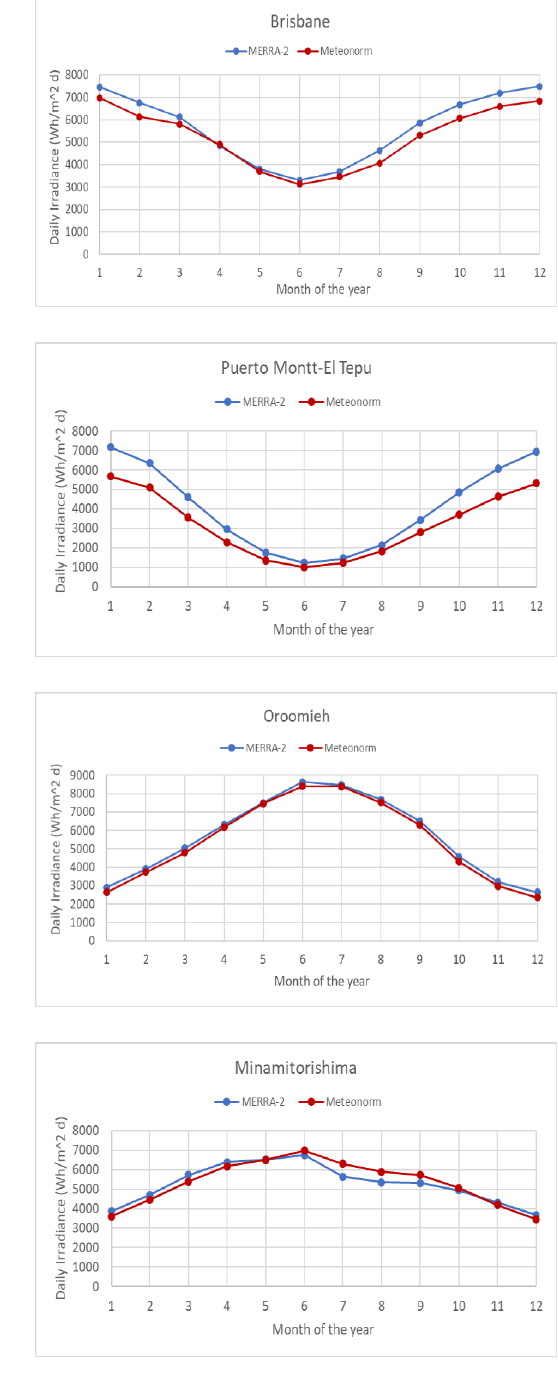
Figure 1. MERRA-2 and Meteonorm comparison for monthly average values of daily irradiance for all locations (through the years from Table 4, column “Radiation period”).